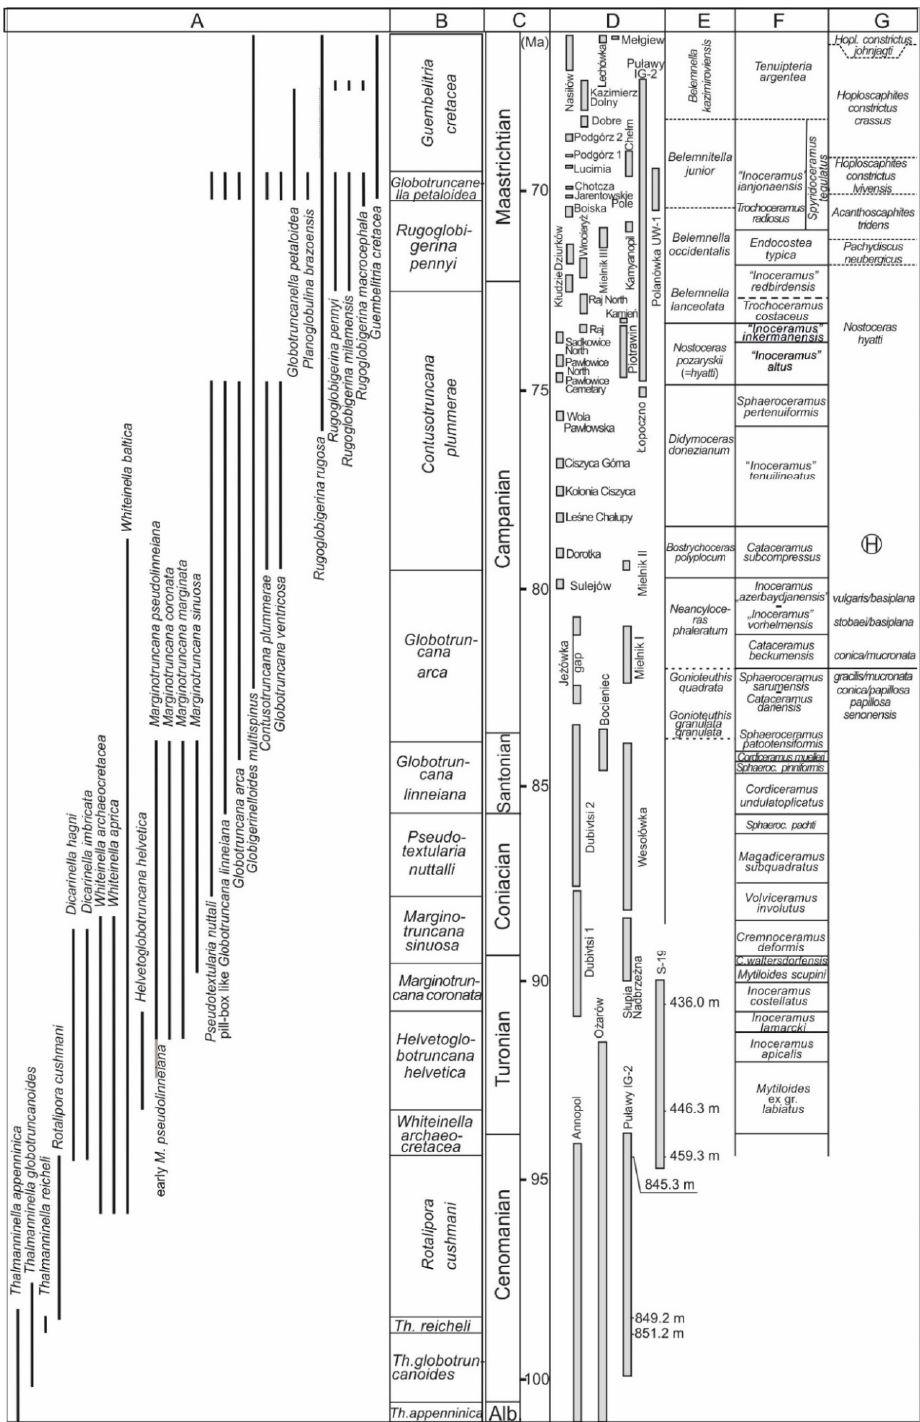
Figure 3. Summary of the planktonic foraminiferal ranges and the proposed biozonation and macrofaunal biozonations for the upper Albian to Maastrichtian of extra-Carpathian Poland and western Ukraine. ( A ) Vertical ranges of index species of planktonic foraminifera; ( B ) proposed biozonation scheme; ( C ) stages and ages after [48]; ( D ) stratigraphical intervals covered by studied successions in several outcrops, quarries and boreholes; ( E ) cephalopod zonation after [49]; ( F ) inoceramid zonation after [18,32,42,43]; ( G ) ammonite zonation after [50,51]; ( H ) belemnite/echinoid